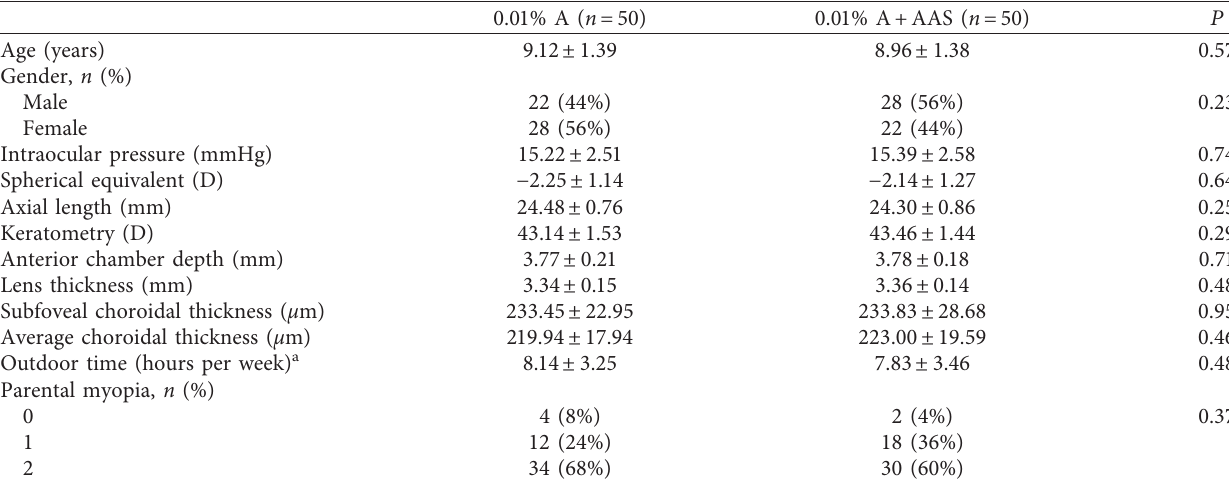
Figure 2: Schematic diagram showing the study flow. Table 1: Baseline characteristics of study